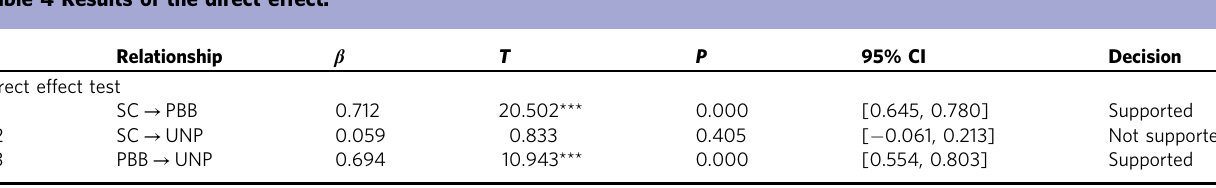
Table 4 Results of the direct